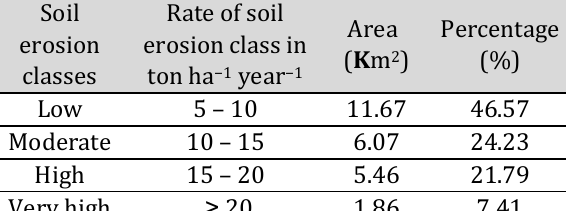
Table 2. Degrees of soil erosion in study